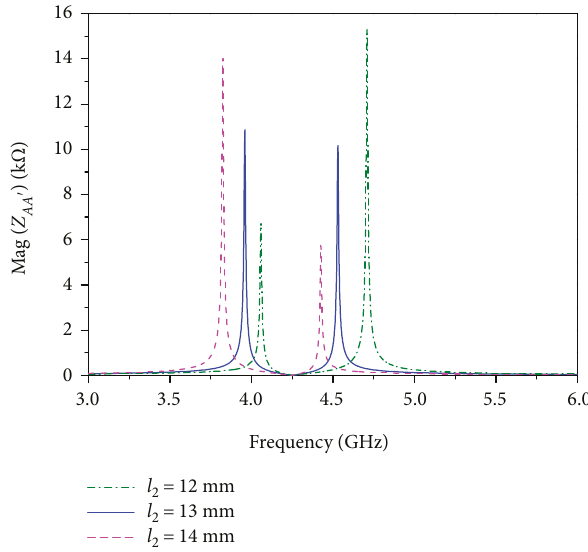
Figure 7: Simulated magnitude of Z